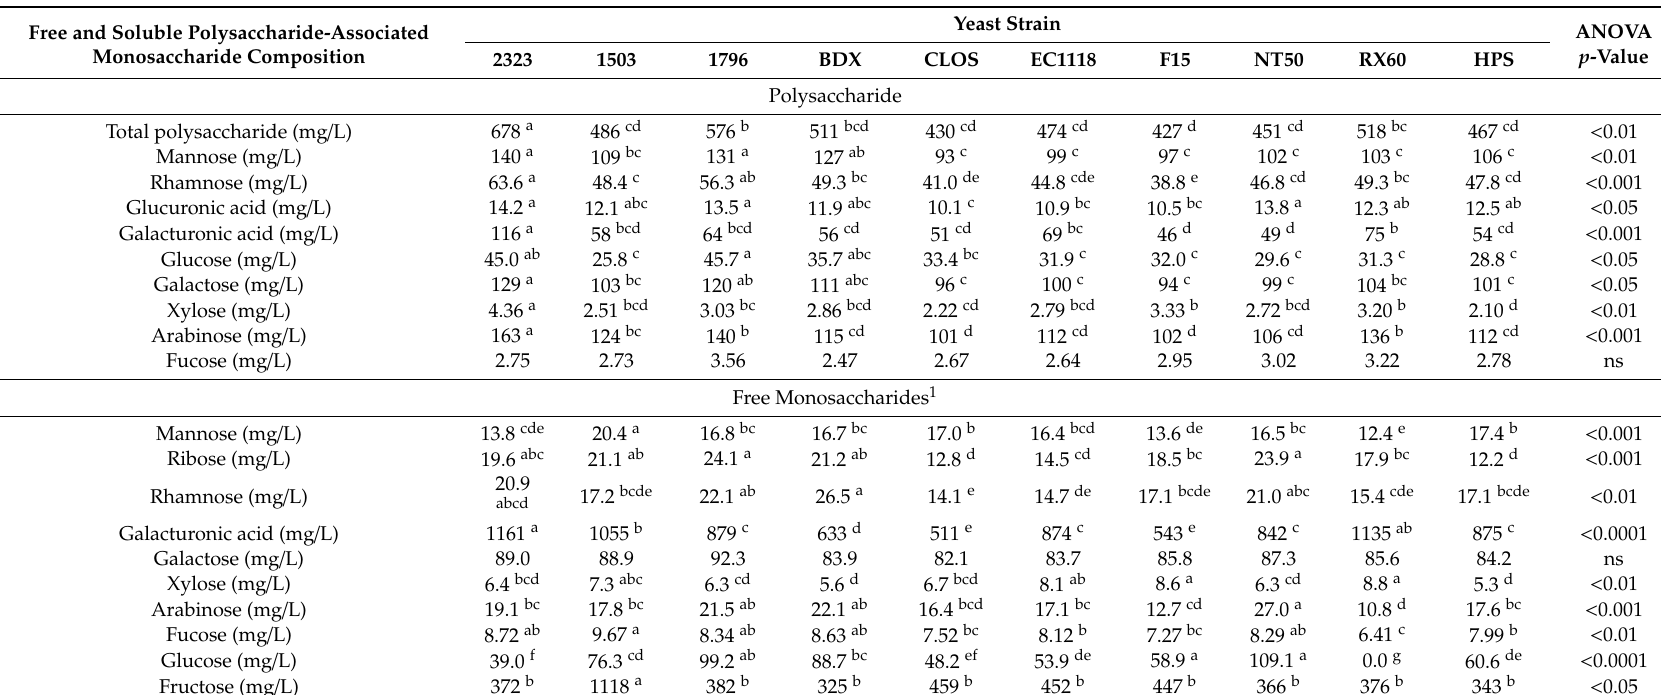
Table 4. E ff ect of yeast strain on wine polysaccharide and monosaccharide composition (data show means compared by one-way ANOVA, where significant di ff erences of p < 0.05 were compared by a post-hoc Student’s t -test, with significant di ff erences within a row shown by di ff erent letters, ns = not significant). Free and Soluble Polysaccharide-Associated Monosaccharide